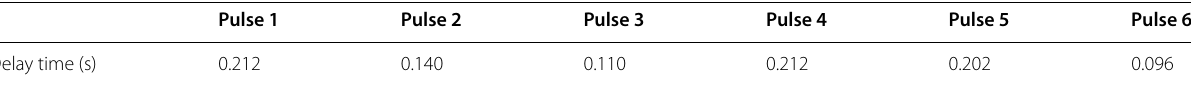
Table 3 Average delay time between WIZ to WSRZ for each of the six eruption pulses